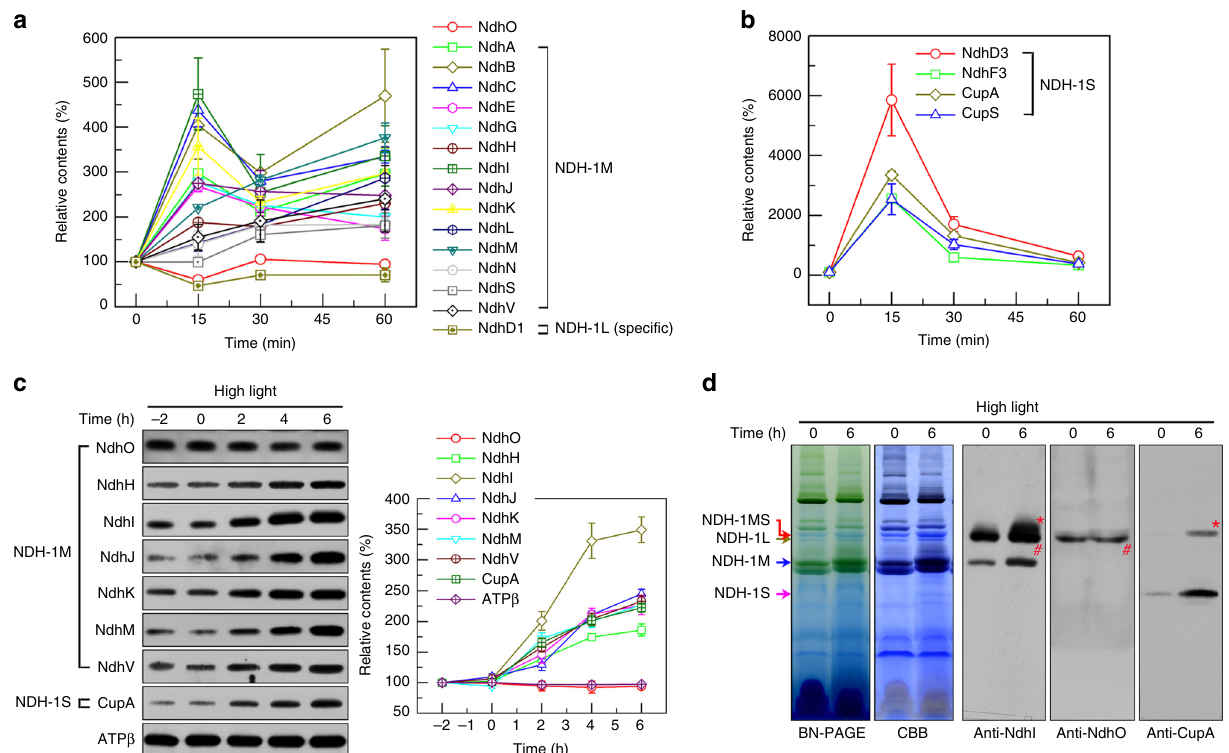
Fig. 5 Regulatory mechanism of NDH-1 in response to high-light exposure. a , b Time course of transcription pro fi les of components of NDH-1M ( a ) and NDH-1S ( b ) after cells were transferred from growth-light to high-light conditions. c Time course of protein-level pro fi les of components of NDH-1M and NDH-1S. ATP β was used as a control. Quanti fi cation of the protein components of NDH-1M and NDH-1S is shown on the right. d Detection of the NDH- 1MS complex and its subcomplexes NDH-1M and NDH-1S before and after 6-h high-light exposure. Red, green, blue, and pink arrows indicate the positions of NDH-1MS (denoted by asterisk (*)), NDH-1L (denoted by hash (#)), NDH-1M, and NDH-1S, respectively. Error bars in the graph represent standard errors of the mean